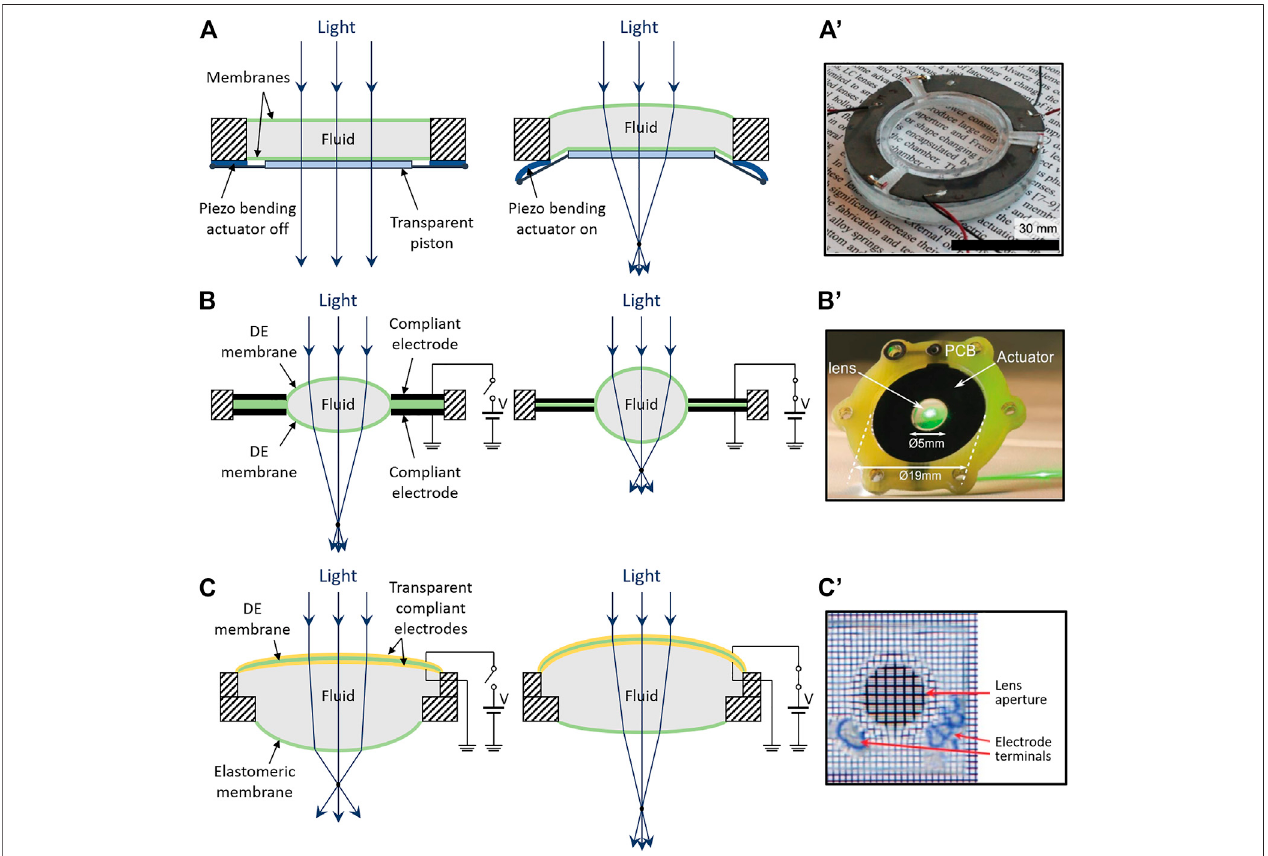
FIGURE 4 | Electro-mechanically shaped encapsulated- fl uid lenses. Structures and principles of operation (left) and photos of examples (right) , for different actuationstrategies: (A) schematicofalensbasedonpiezoelectricbendingactuators,whichtranslateapistonthatdisplacethe fl uid; (A 9 ) prototypesample,reproduced with permission from (Hasan et al., 2017); (B) schematic of a lens based on an annular DE actuator, which radially compresses the central lens; (B 9 ) prototype sample, reproduced with permission from (Maf fl i et al., 2015); (C) schematic of a lens based on a transparent DE actuator embedded on the surface, which increases its curvature; (C 9 ) prototype sample, reproduced with permission from (Shian et al., 2013).